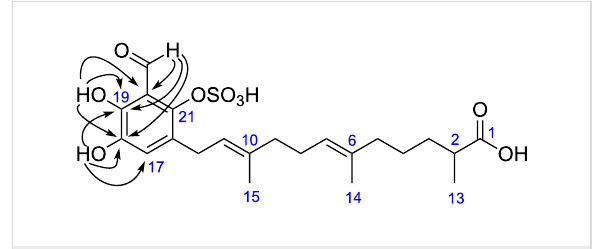
Figure 4: Selected 1 H, 13 C-HMBC correlations (H → C) observed for siphonodictyal E2 ( 2 ).